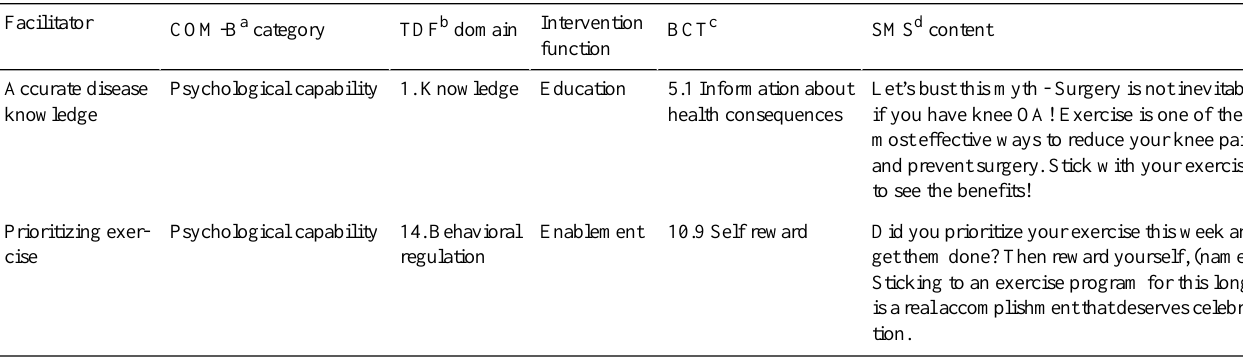
Table 3. Example mapping of facilitator behavior change technique messages following the behavior change wheel framework. OA: